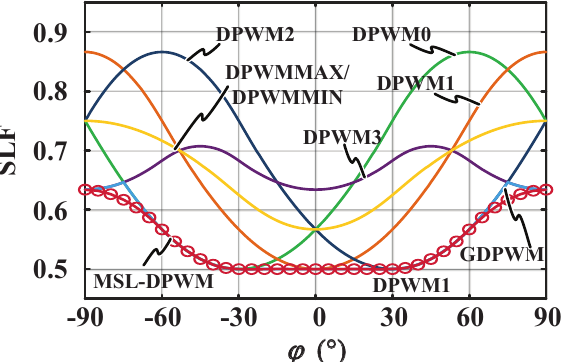
Figure 5. Switching loss functions of various DPWM